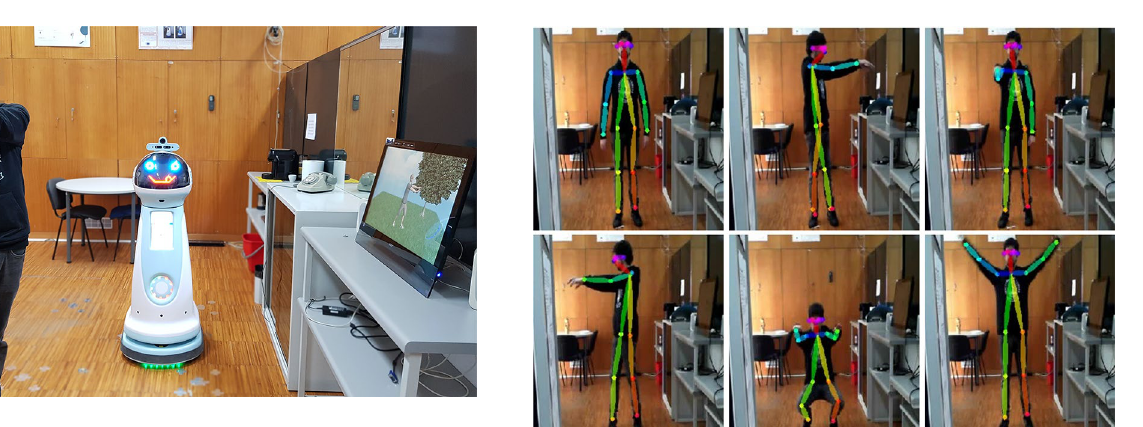
Fig. 4 Samples from exercise sequence showing the user body pose extraction by